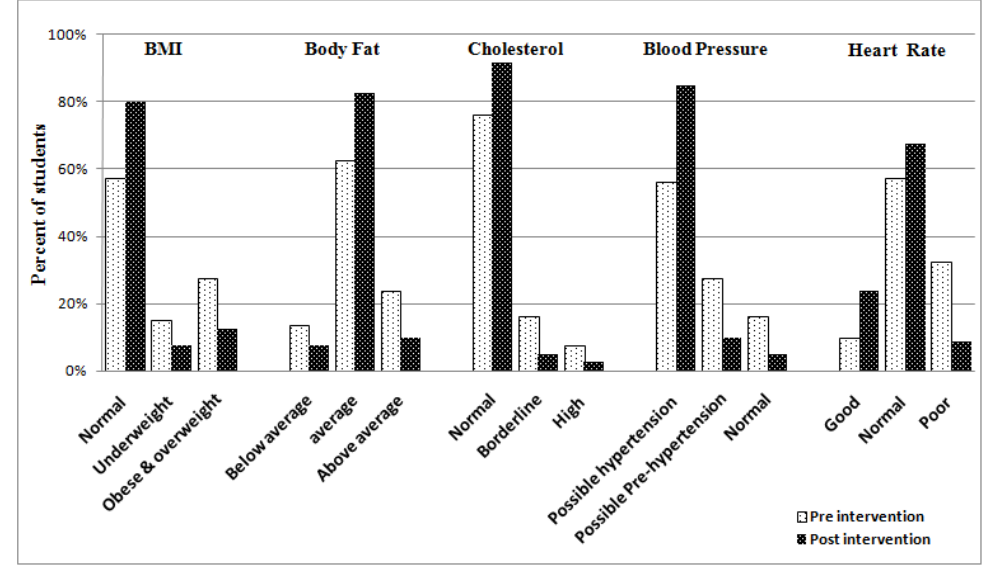
Figure 4. Anthropometric and physiological parameters of intervention pupils after 3 months.